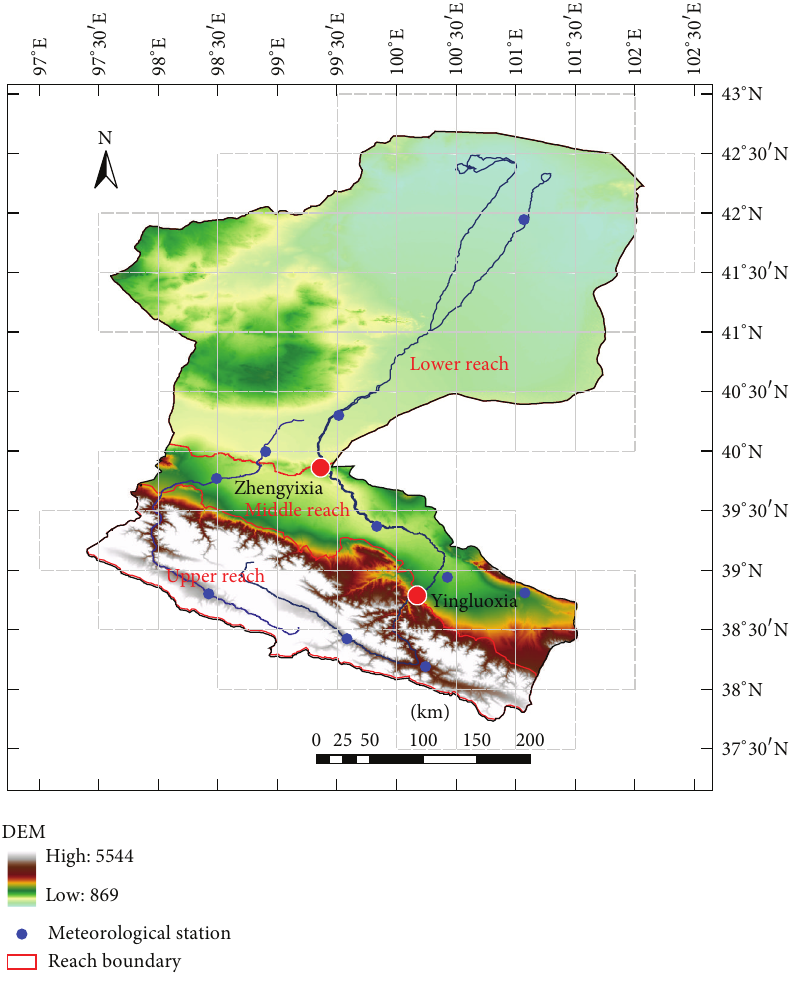
Figure 1: The study area with 0.5-degree grid